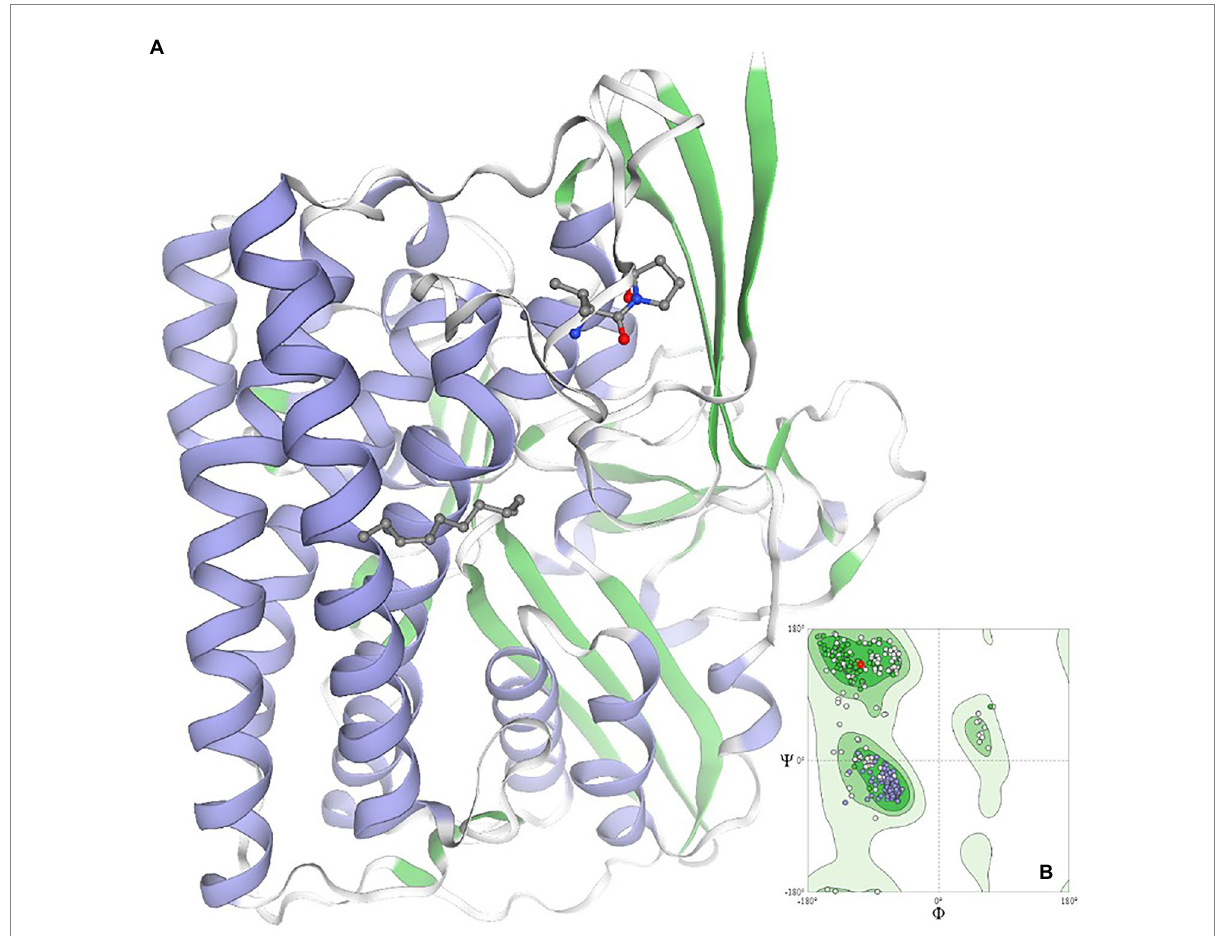
FIGURE 6 Homology modeling of the quorum quenching homolog in the case of Oleidesulfovibrio alaskensis G20*. Ramachandran plot is given as an inset image validating the structural conformation of the model as >98% of residues exist in the favored region *quorum quenching molecule encoded by gene ID Dde_2135 in Oleidesulfovibrio alaskensis G20 is homolog of HysB of Desulfovibrio vulgaris